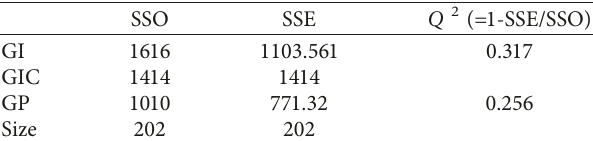
Table 9: Construct cross validated